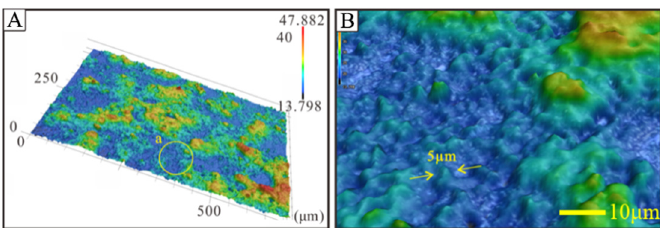
Figure 3. 3D topography of the polished base coating surface. ( A ) After 15 sprays; ( B ) enlarged image.